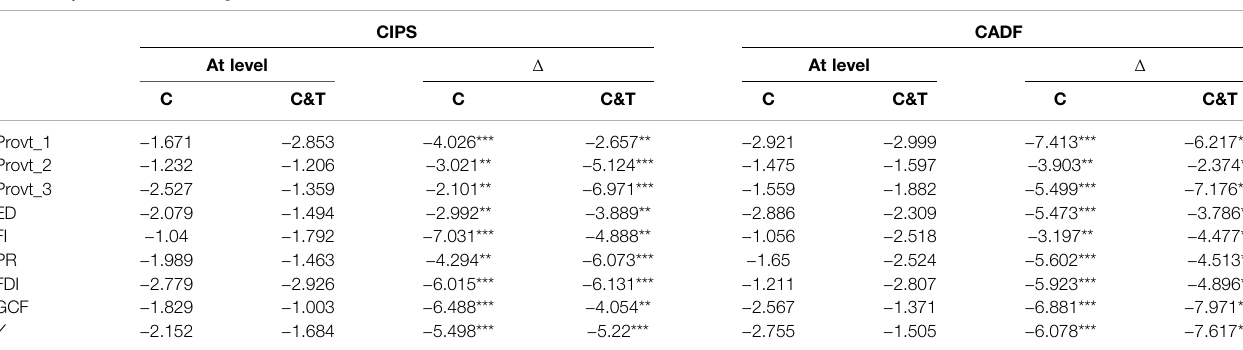
TABLE 7 | Results of second-generation unit root